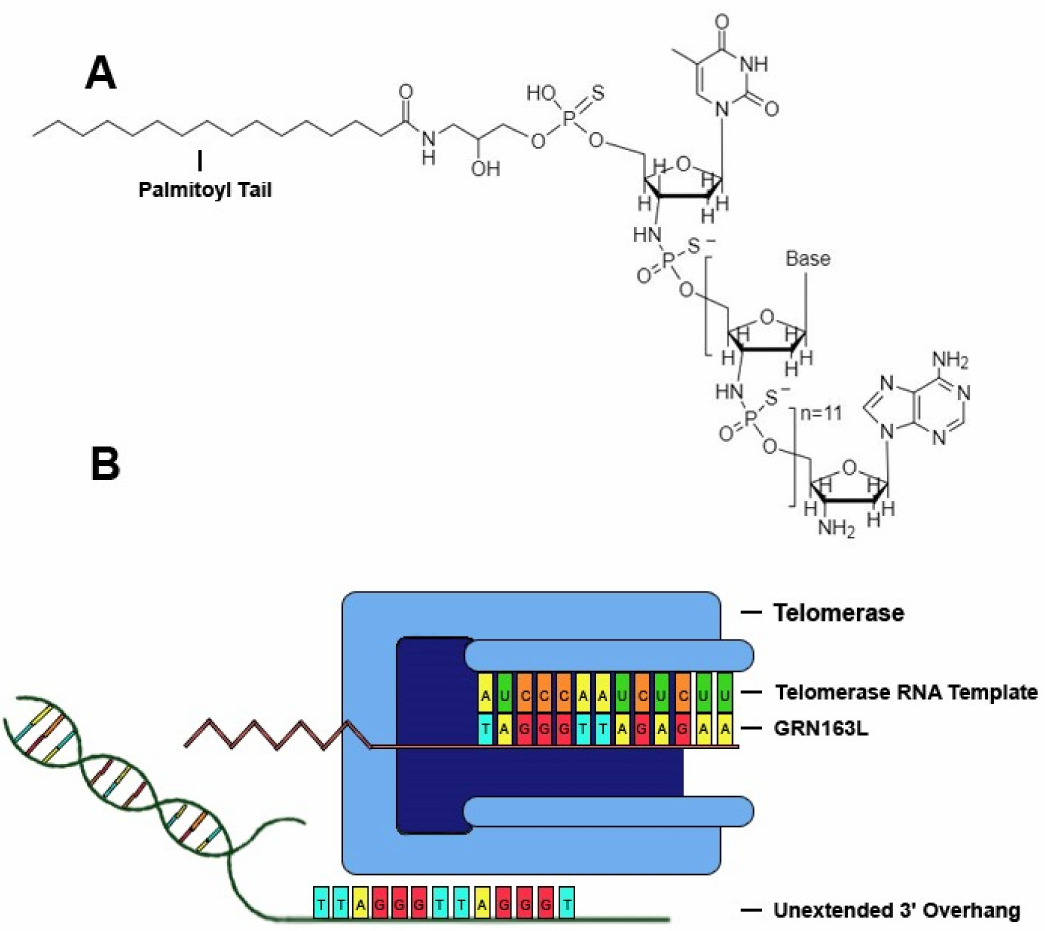
Figure 1. GRN163L inhibits telomerase by binding to hTR. ( A ) Chemical structure of GRN13L. GRN163L is a 13-mer oligonucleotide that base pairs to the RNA template of telomerase. The palmitoyl group bound to the 5 (cid:48) -thio-phosphate group enhances cellular uptake and retention. ( B ) GRN163L base pairs to the RNA template of telomerase, preventing elongation of the 3 (cid:48)